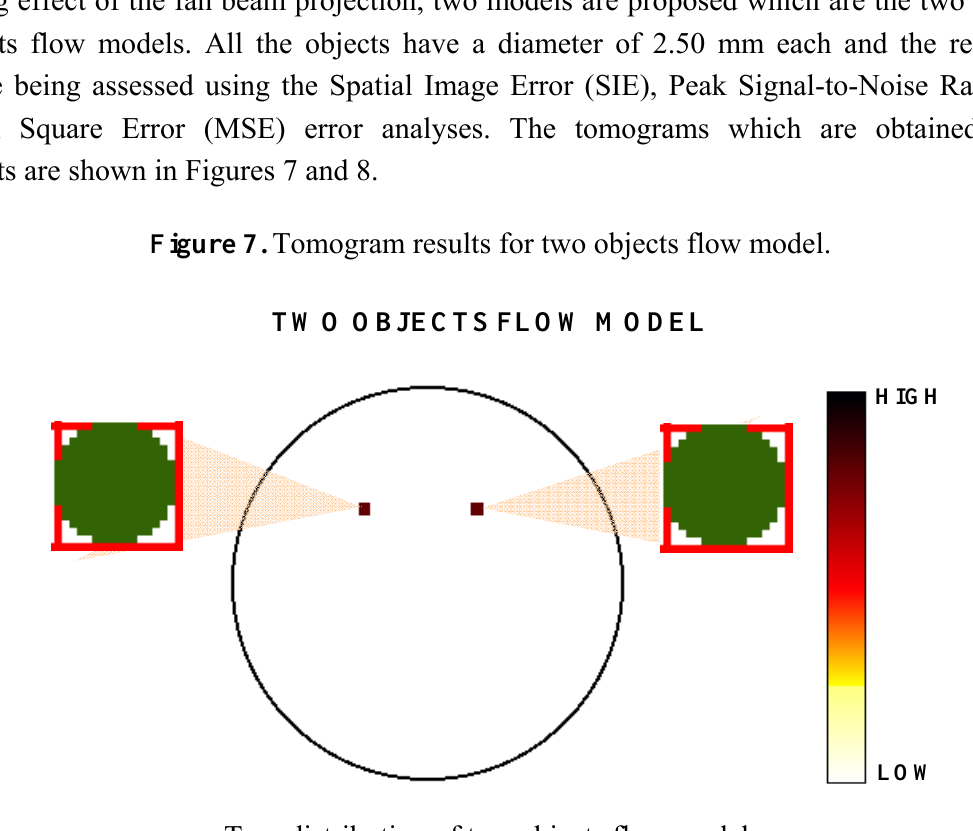
True distribution of two objects flow